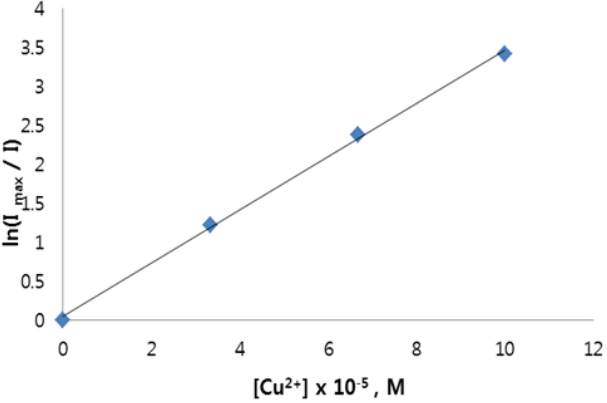
Figure 7. A linear fitting diagram showing the modified (natural log-dependent) Stern-Volmer relationship between the ZnS:Mn-Asp NCs and the added Cu 2+ ions. ( R 2 = 0.9989, and the quenching rate constant k = 3.14 × 10 4 M −1 ).